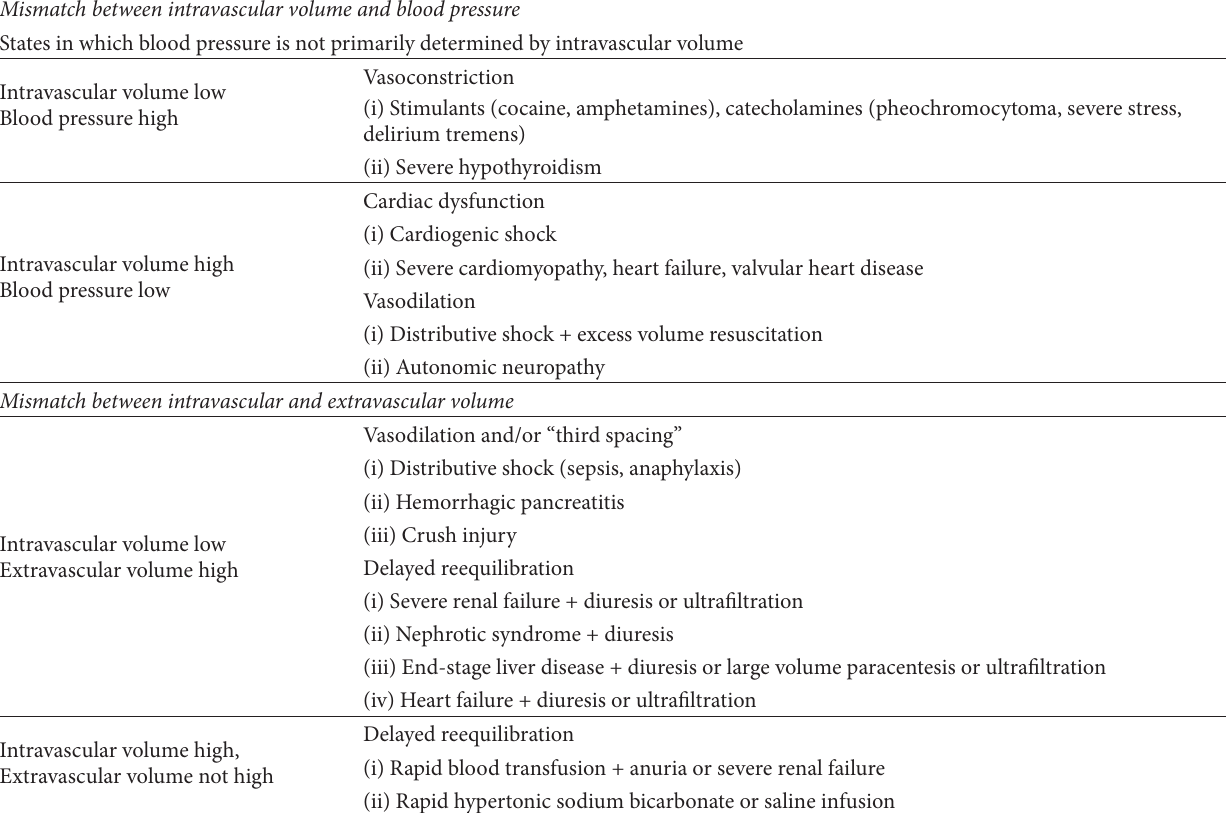
Table 3: Mismatch between intravascular volume and blood pressure or extravascular volume. Mismatch between intravascular volume and blood